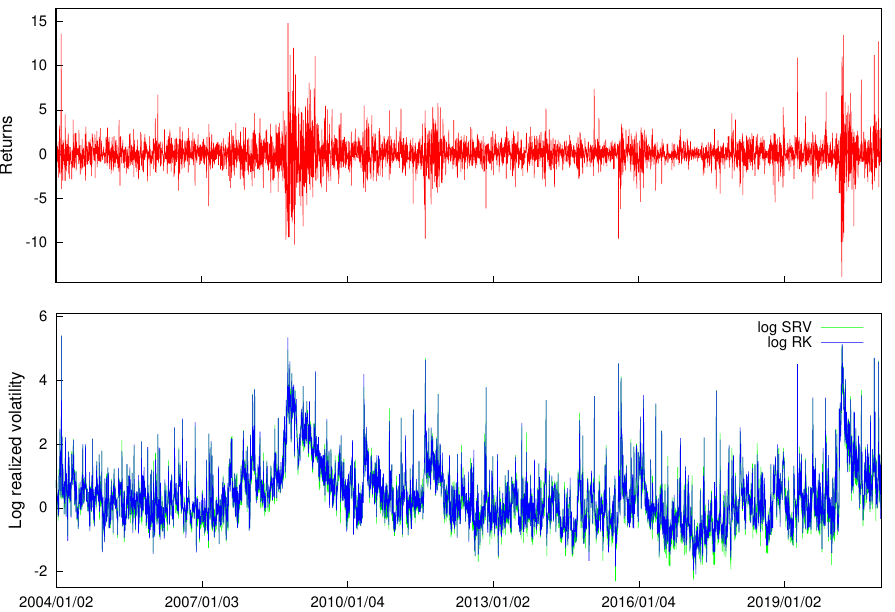
Figure 1. Daily returns and logarithmic realized volatility measures of DIS.